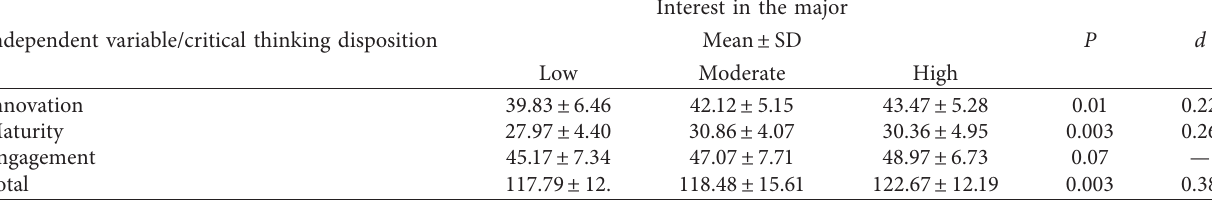
Table 4: Total score of critical thinking disposition and scores of its dimensions by interest in the